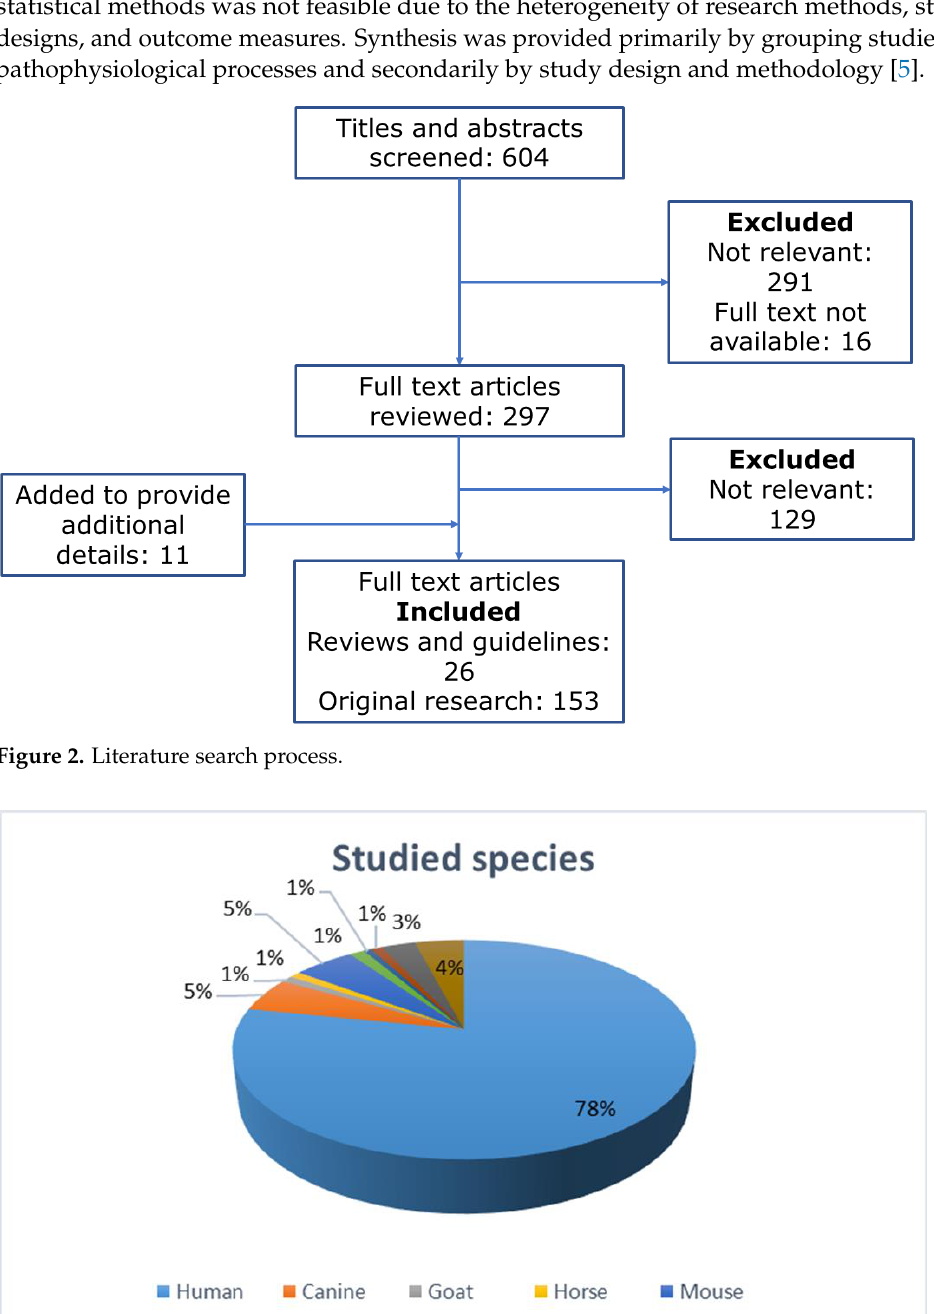
Figure 3. Species analyzed in the cited literature. One study may have investigated more than one species. The majority (78%) of the studies investigated human experimental or clinical processes. Several studies (4%) included mathematical models and simulations. Canine and mouse models were the most studied animal models of persistent AF in the past 10 years (5%